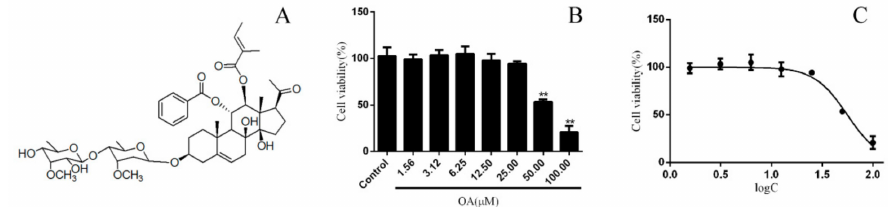
Figure 1. The cytotoxicity of Obcordata A (OA) on HK-2 cells. ( A ) The structural formula of OA. ( B ) The cytotoxicity to HK-2 cells at di ff erent concentrations of OA. Cells were incubated with di ff erent doses of OA for 24 h. Cell viability was measured using the MTT assay. OA has a significant inhibitory e ff ect on the proliferation of HK-2 cells at concentrations above 50 µ M. ( C ) The IC 50 value of OA to HK-2 cells. The IC50 value was obtained by fitting cell viability with the drug concentration logarithm. n = 3 independent experiments. ** P < 0.05 versus control